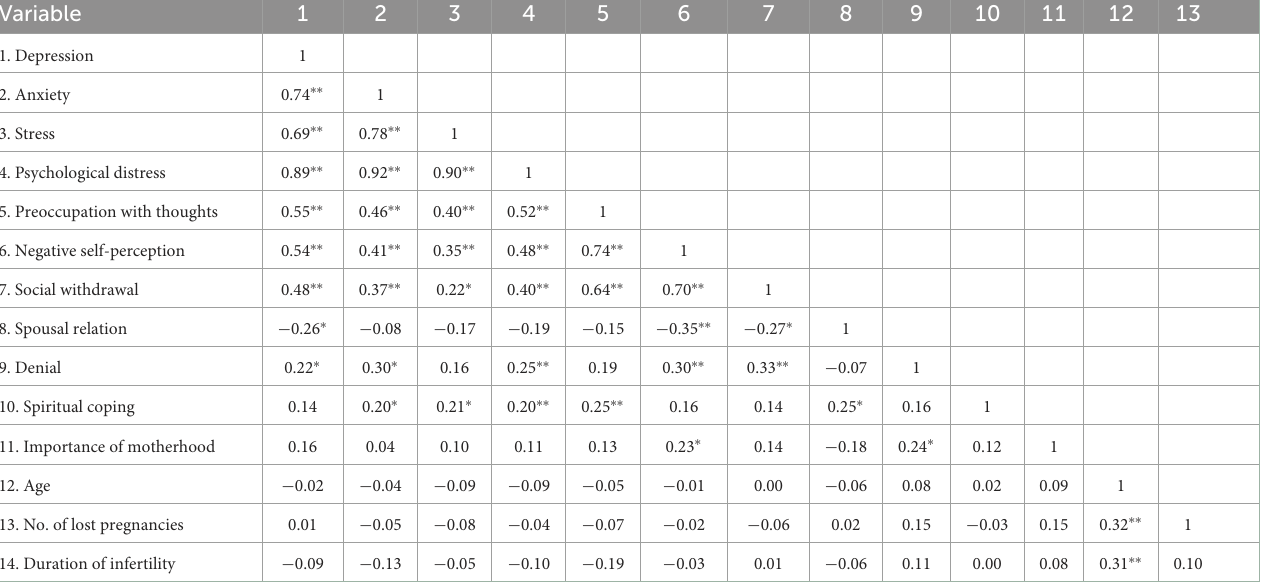
TABLE 3B Zero-order correlations among the main variables—women undergoing ART ( N = 102). Variable